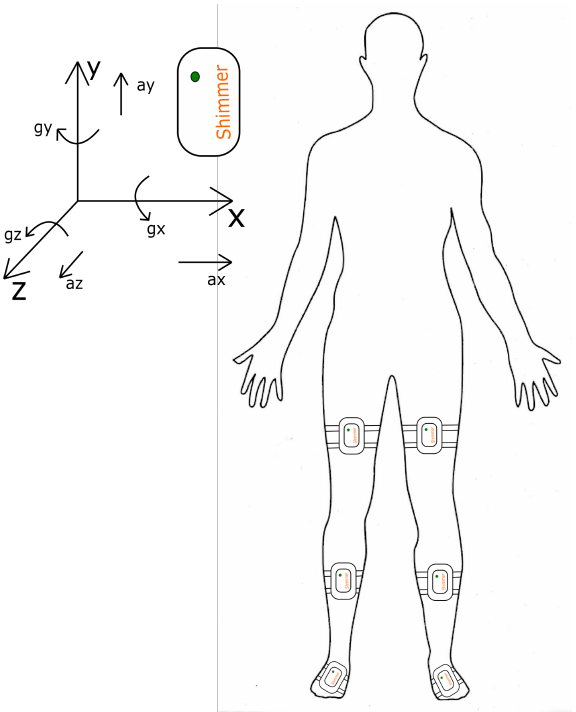
Figure 1. Wireless sensors fixed on the lower limb